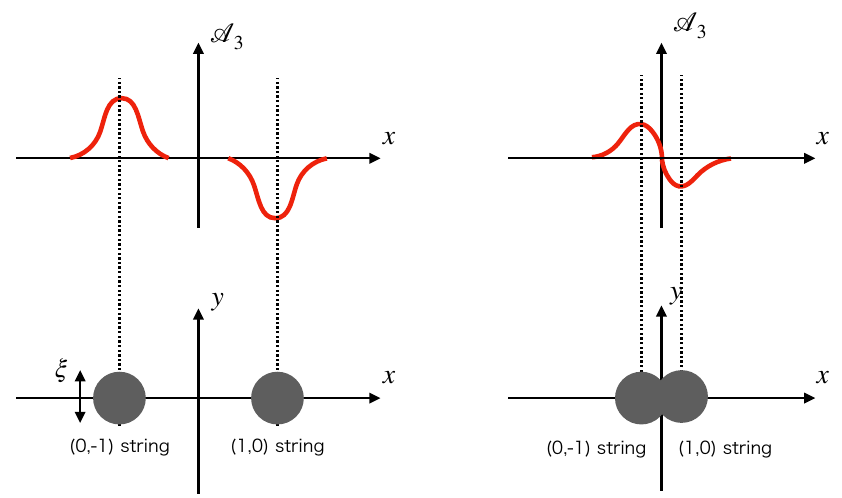
Figure 4 . Schematic picture for the distribution of the topological current A 3 for the (1 , 0) - and (0 , − 1) -strings (represented by the gray regions). ξ is the typical length scale of the string core. The left panel shows the well-separated case, in which A 3 has negligible overlap, and hence the vortex molecule consisting of the two strings does not decay as long as they are well-separated, namely, R is sufficiently large compared with their core sizes. The right panel shows the non-separated case, in which A 3 has finite overlap and its shape is deformed. The molecule is not stable and decays as the non-topological Z